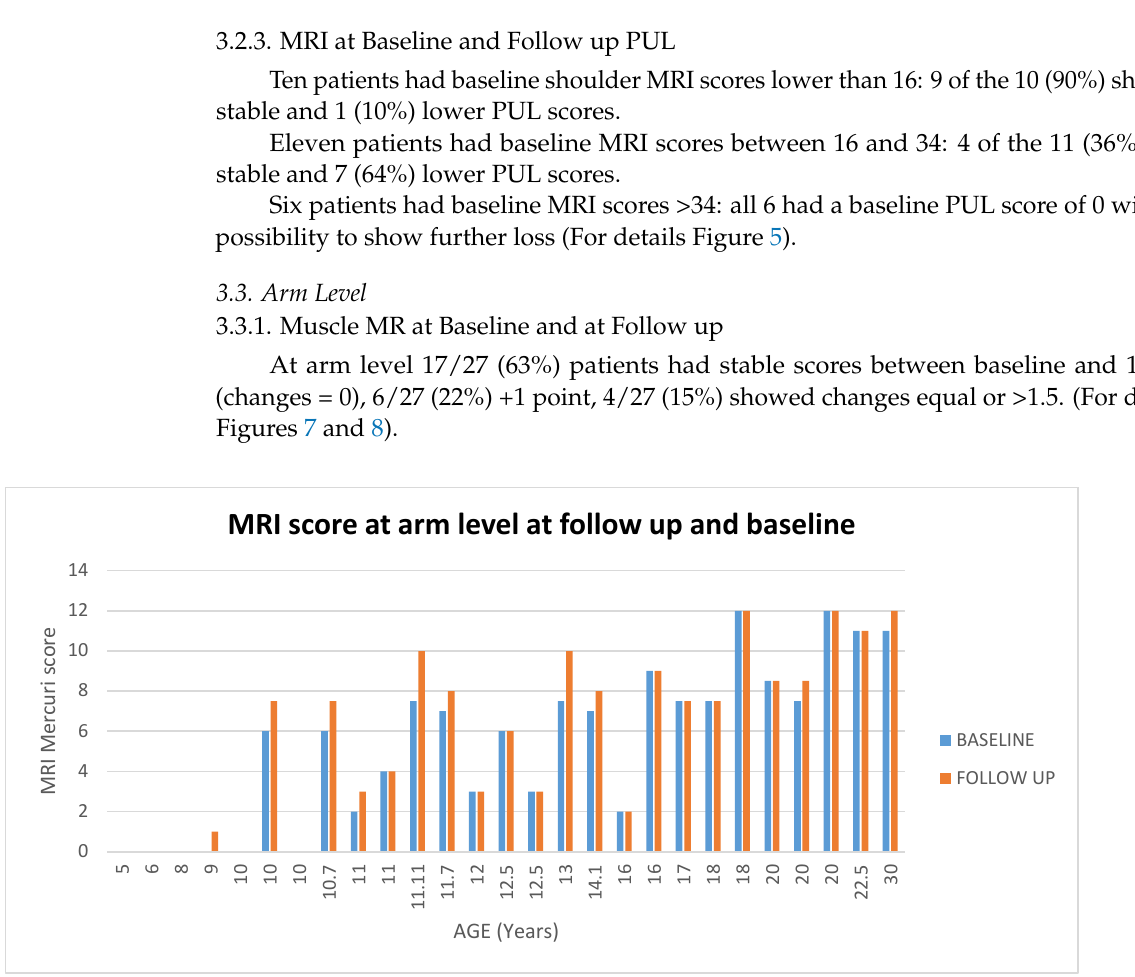
Figure 6. Showed scores in PUL at shoulder level at baseline and at follow up according to age.